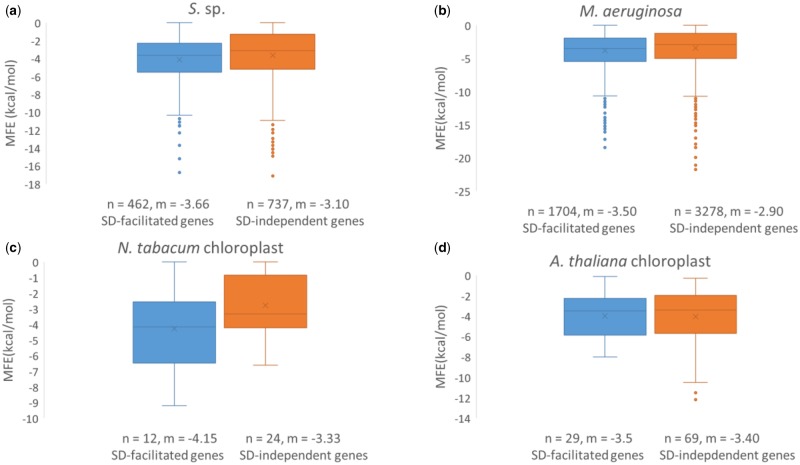
—Contrasts in MFE (kcal/mol) at the 40 nt initiation region immediately upstream of the start codon between SD-facilitated genes (SD/anti-SD pair ≥4 nt and optimal DtoStart) and SD-independent genes in (a) S. sp., (b) M. aeruginosa, (c) N. tabacum chloroplast, and (d) A. thaliana chloroplast. All genes are non-pseudo with nonzero protein abundances. For each gene set, the number of genes (n) and median (m) is denoted under the boxplots.